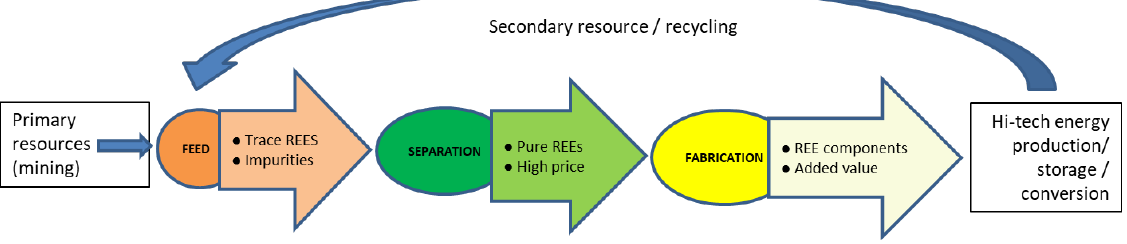
Figure 1. Lifecycle of REE resources in energy production/storage/conversion systems and scope of the present review.